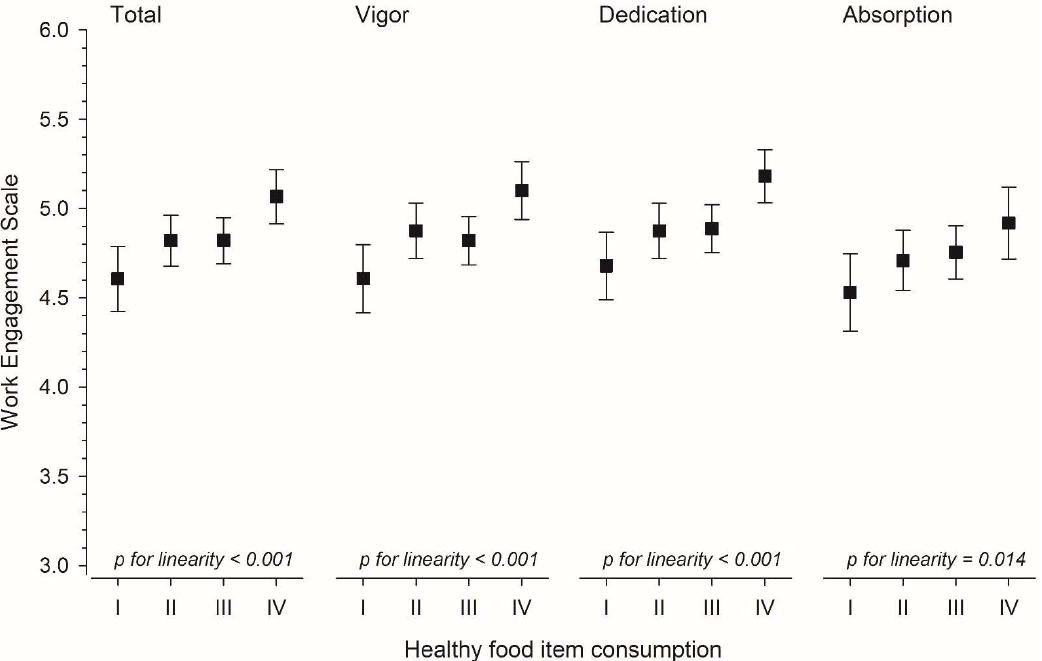
Figure 1. Mean with 95% confidence intervals of total work engagement and its subscales (adjusted for age, education years, financial situation, and physical activity hours per week) according to the categories of healthy food items consumed per day. Nutrients 2022 , 14 , x FOR PEER REVIEW